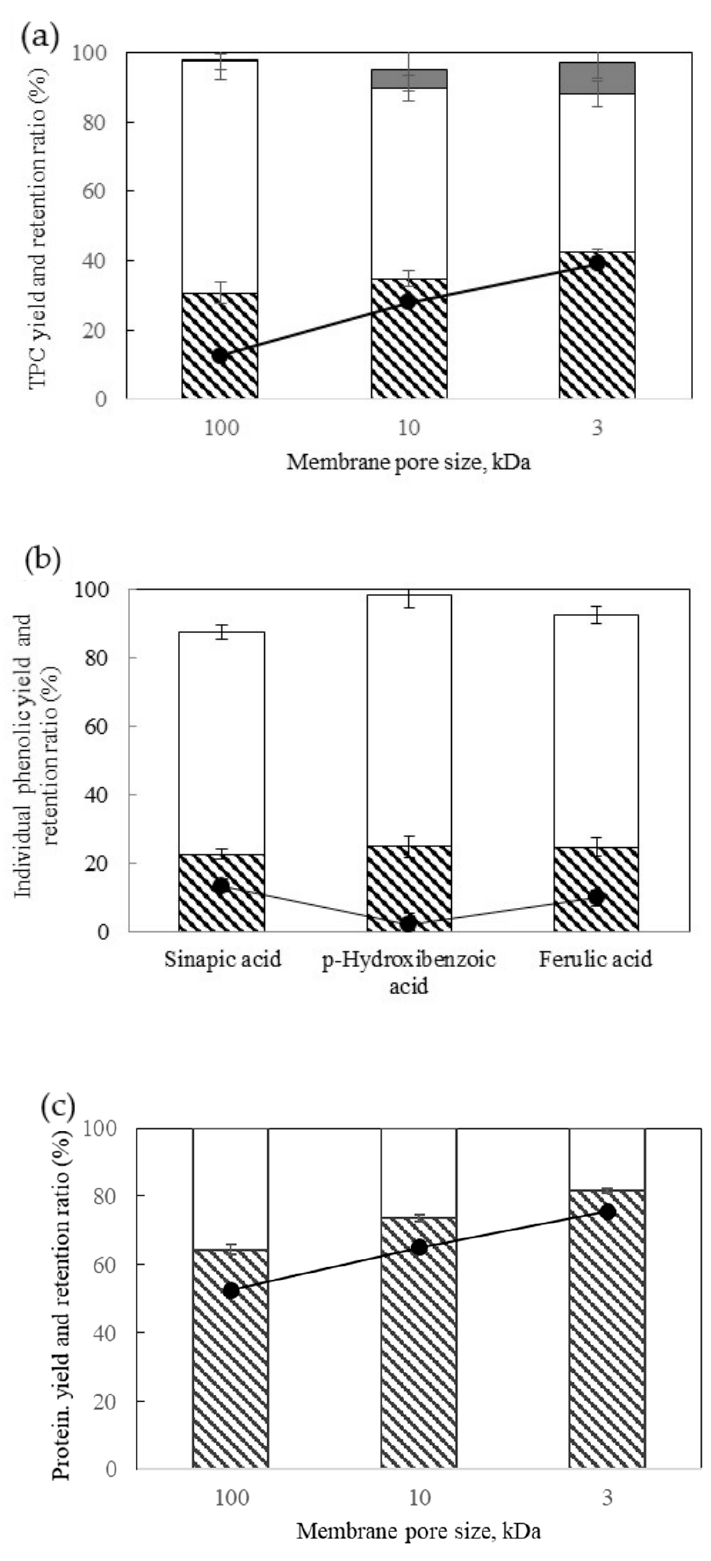
Figure 7. Permeate/retentate yield and retention ratio at different membrane NMWL ( 7a ) TPC ( 7b ) Figure 7. Permeate / retentate yield and retention ratio at di ff erent membrane NMWL ( a ) TPC individual phenolic compounds at 10 kDa membrane size ( 7c ) protein. Columns represent the yield ( ( b ) individual phenolic compounds at 10 kDa membrane size ( c ) protein. Columns represent the yield ▧ rententate yield, □ permeate yield, ■ TPC adsorbed in the membrane), ● retention